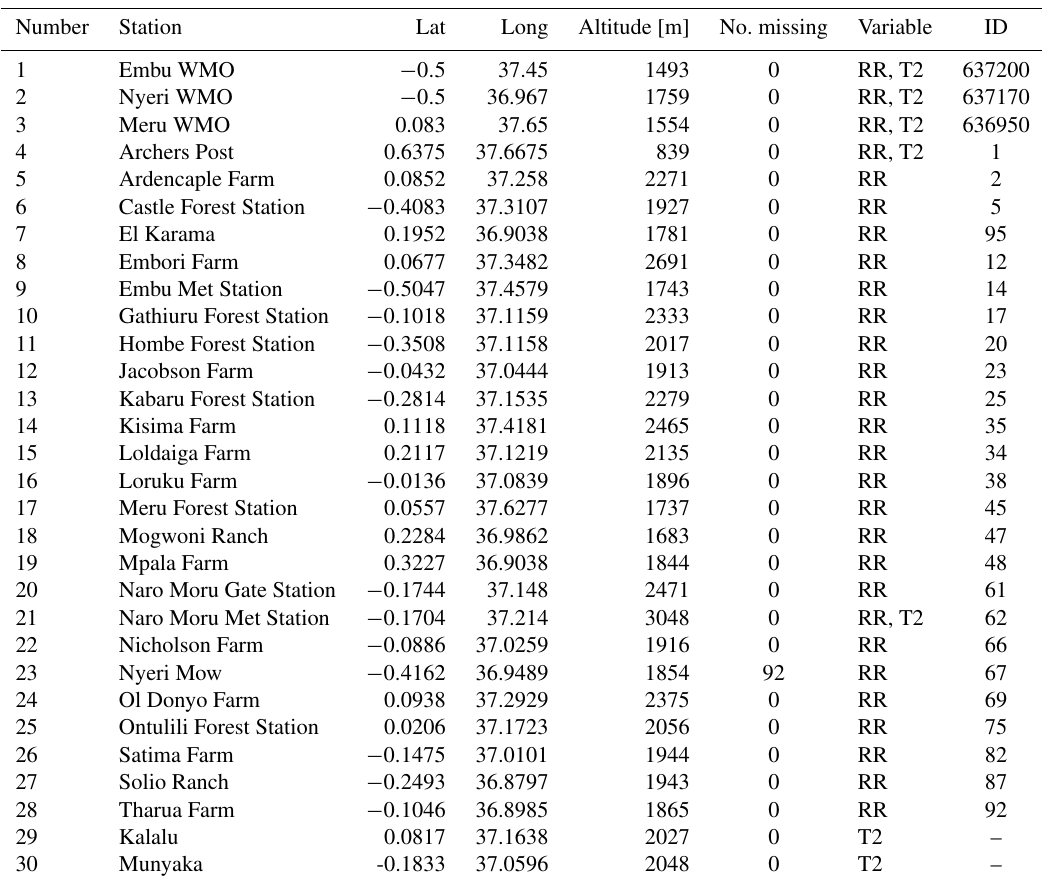
Table 2. Weather station information: station number used in our study (labels in Figs. 1, 6, and 7), station name, location (latitude and longitude), altitude (in metres above sea level), number of missing values, variables available, and station ID from WMO (first three lines) or from Table 1 in Schmocker et al. (2016). RR stands for precipitation and T2 for 2m